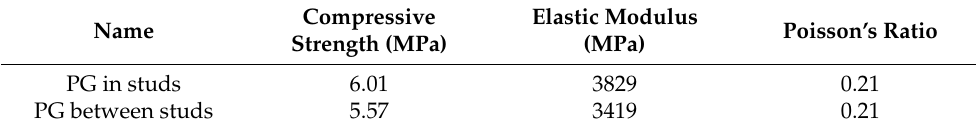
Table 3. Mechanical properties of PG.